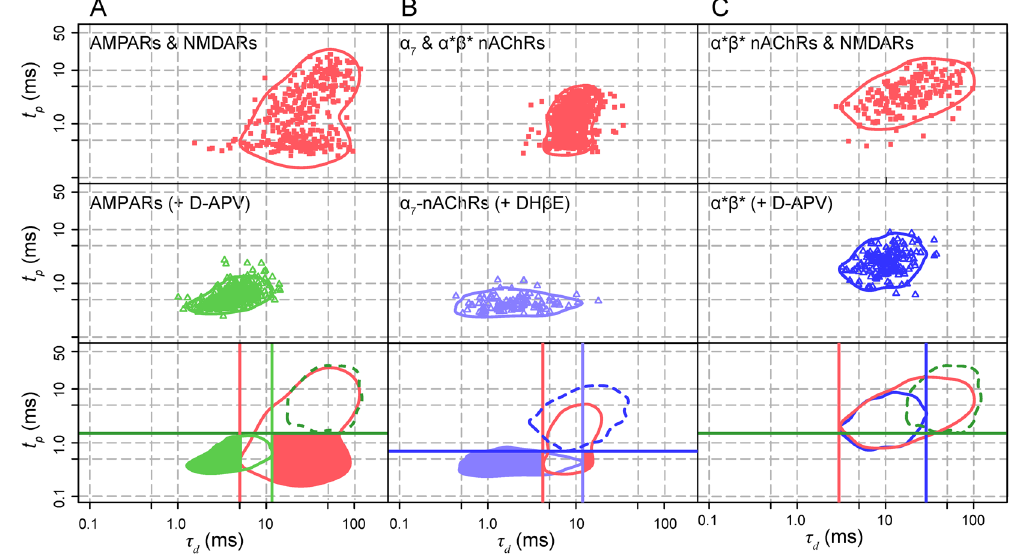
Figure 4. Co-localization of post-synaptic receptors deduced from single cell experiments. Left column . Co-localization of AMPARs and NMDARs. Glutamatergic mEPSCs were collected at − 40 mV. The upper plot (red) shows the distribution of the 345 mEPSCs in two-receptor conditions. The middle plot (green) shows the distributions of the 473 mEPSCs obtained after addition of D-APV. In the lower plot the two distributions are superimposed on the envelope of the distribution (dotted line) obtained from multiple single-receptor NMDARs,experiment (green dotted line).This allows the calculation of µ = 149/345 = 0.43 and α * ß * nAChRs. Nicotinic mEPSCs were collected ϕ = 326/473 = 0.69. Middle column . Co-localization of α 7 and at − 60 mV. Upper row (red): 585 mEPSCs recorded in the two-receptor conditions. Middle row (purple): 110 α 7 nAChR mEPSCs recorded after addition of DHßE. Lower row: Superimposition of the two distributions obtained with the envelope of a third distribution (blue dotted line) obtained from pooled single-receptor α * ß * nAChR experiments (Fig. 1B). This allows the calculation of µ = 26/585 = 4.4% and ϕ = 96/110 = 87.3%. Right column . Absence of mixed mEPSCs associating α * ß * nAChRs with NMDARs. mEPSCs were collected at at − 40 mV. Upper row (red): distributions of the 187 mEPSCs in two-receptor conditions ( α * ß * nAChRs and NMDARs). Middle row: distributions of the 285 mEPSCs obtained after addition of D-APV (blue). Lower row: superimposition of the distributions obtained in each of the two cells with the envelope of distributions for NMDARs mEPSCs obtained from pooled single-receptor experiments (green dotted line). This leads to the values of µ = 2/187 = 1.0% and ϕ = 0/160 =